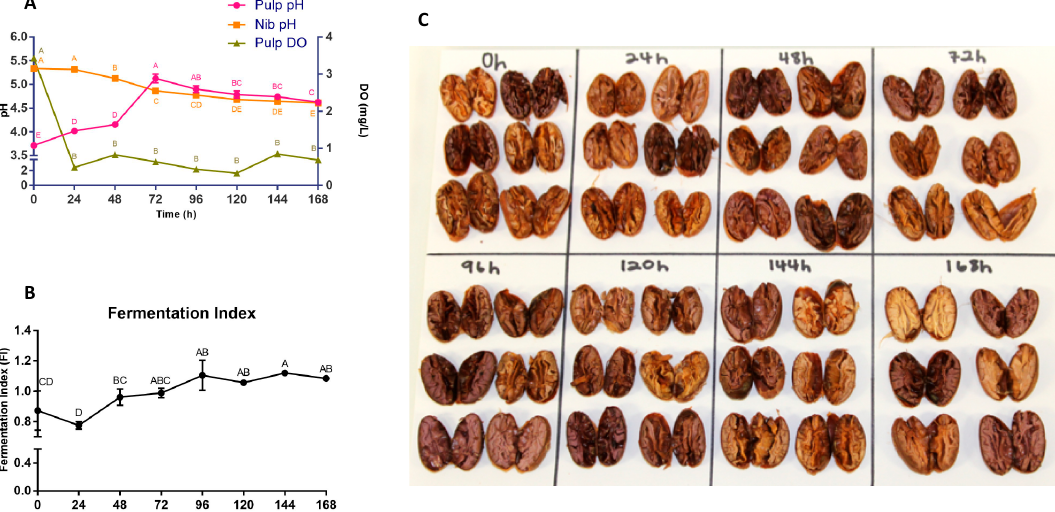
Figure 1. ( A ) pH measurements for both simulated pulp media and bean nib. It is important to note that, for bean nib measurements, these values do not quantify the pH of the cocoa bean itself, but rather of the acidity derived when bean acids are diluted in water. These nib values are useful for comparison between the pH of the solution produced by beans at different time points. Dissolved oxygen (DO) measurements within the simulated pulp media are expressed in mg/L. ( B ) Fermentation index (FI) expressed as a ratio of absorbance at 460 and 530 nm. ( C ) Cut test of six randomly selected beans per each timepoint. Beans were selected from both fermentation treatments to form one composite representation. Values are presented as the mean ± SEM of fermentation replicates. Significance between time points for each value was determined by one-way ANOVA and Tukey’s HSD post-hoc test ( p < 0.05). Time points with different letters are significantly different within values.